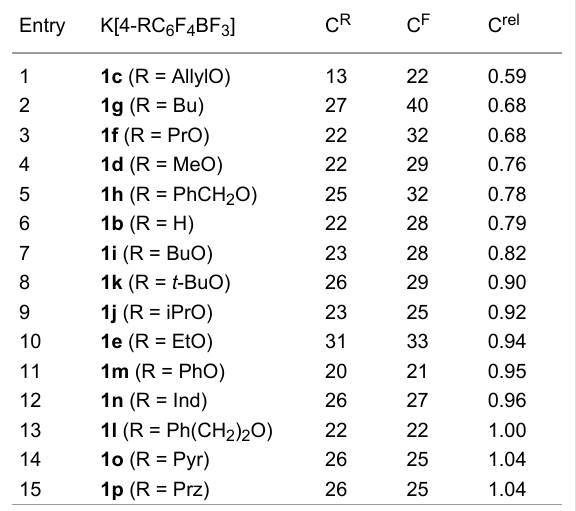
Table 3: Relative reactivity C rel of K[4-RC 6 F 4 BF 3 ] in the cross coupling with 11 . a,b